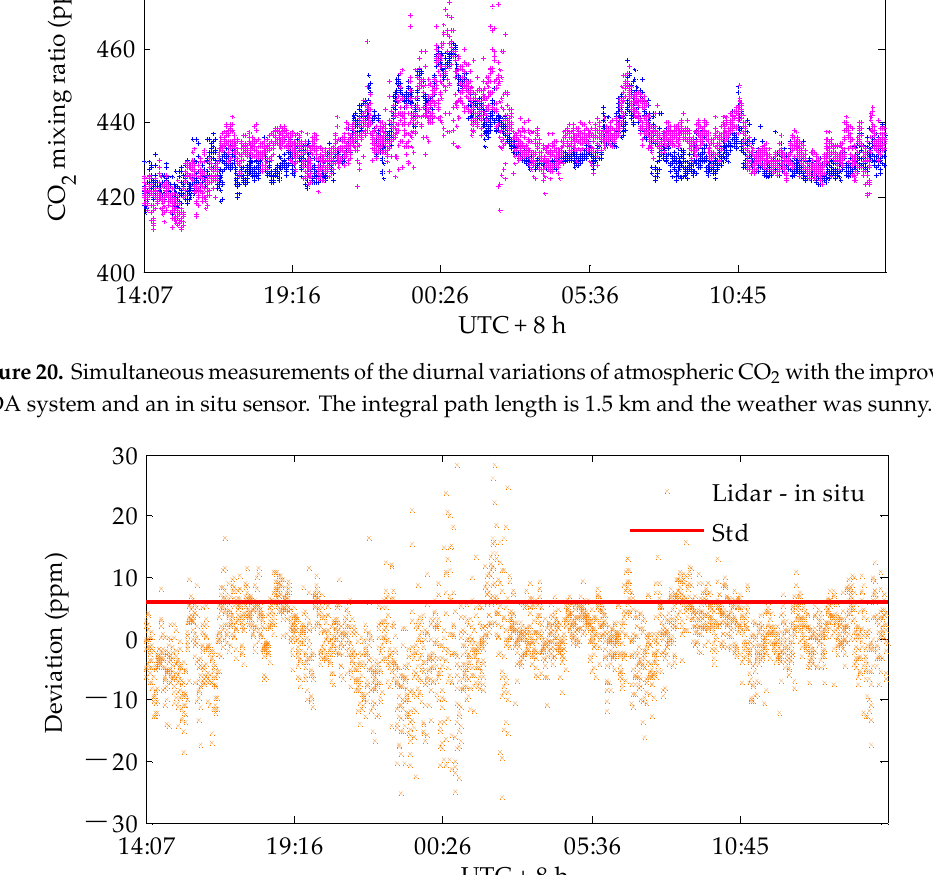
Figure 21. The discrepancy between the measured CO 2 concentration by the IPDA system and in situ sensor on the 1.5 km horizontal path.